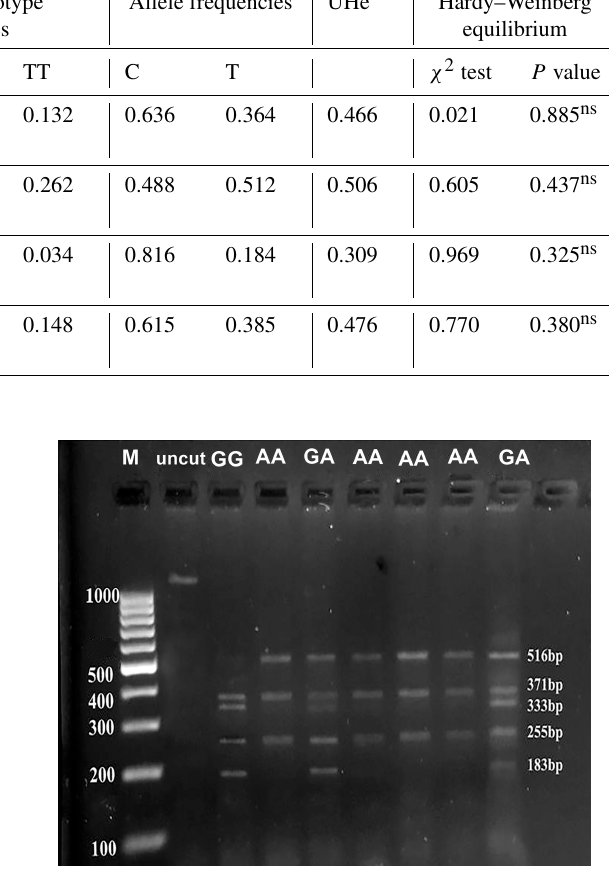
Figure 2. Agarose gel electrophoresis (3%) showing PCR RFLP and genotyping of the AA-NAT exon 3. M: 100bp DNA lad- der; uncut, 1142bp. Lanes represent the genotypes GA (516, 371, 333, 255, 183bp), GG (371, 333, 255, 183bp) and AA (516, 371,